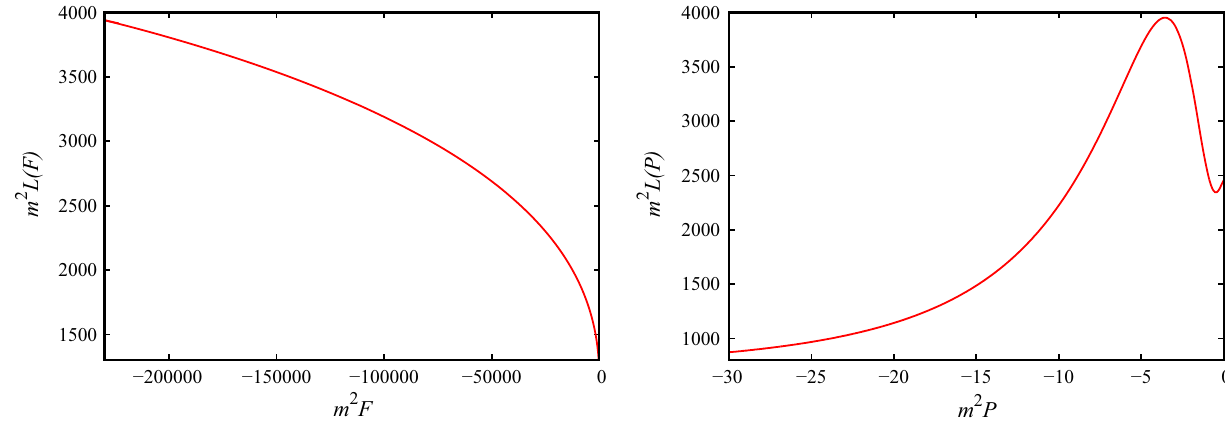
Fig. 4 Graphical representation of L ( F ) and L ( P ) with mc 1 = 1 and q = 0 . 4